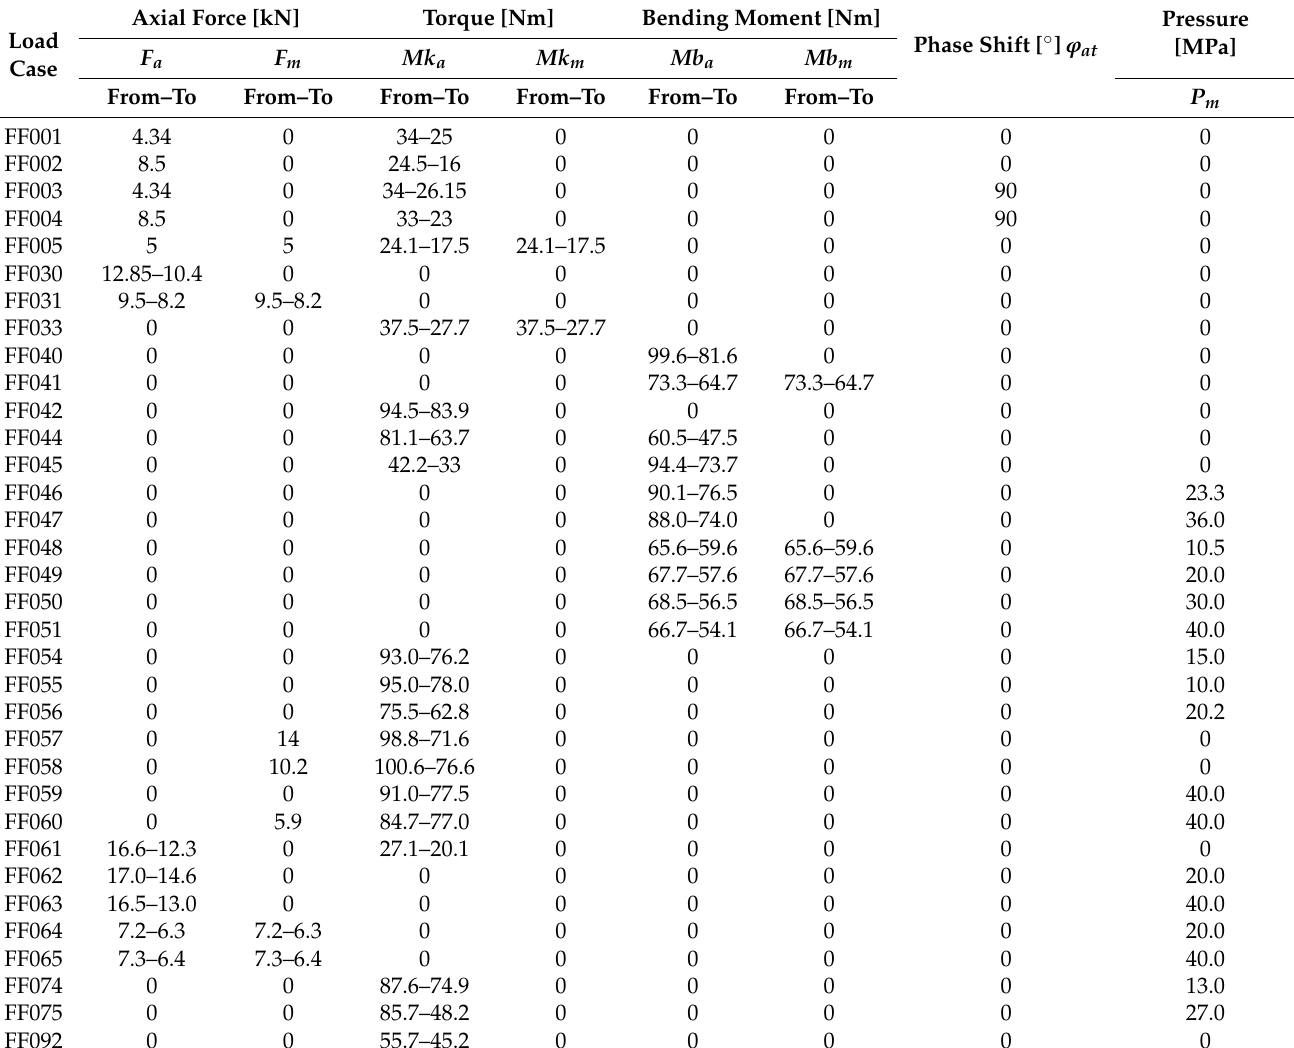
Table 4. Summary of all load cases as regards to the range of applied forces, moments and pressures; also, the phase shift ϕ at between the axial and torsion load signals is